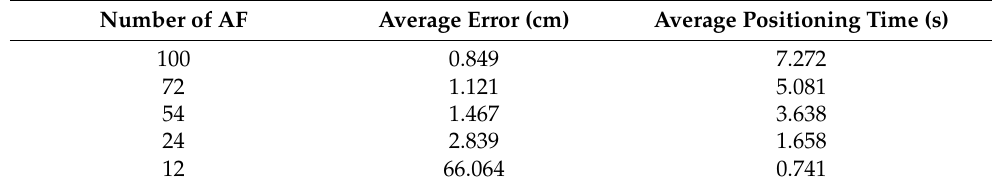
Table 10. Total average error and positioning time when the number of AFs is 100, 72, 54, 24, and 12.